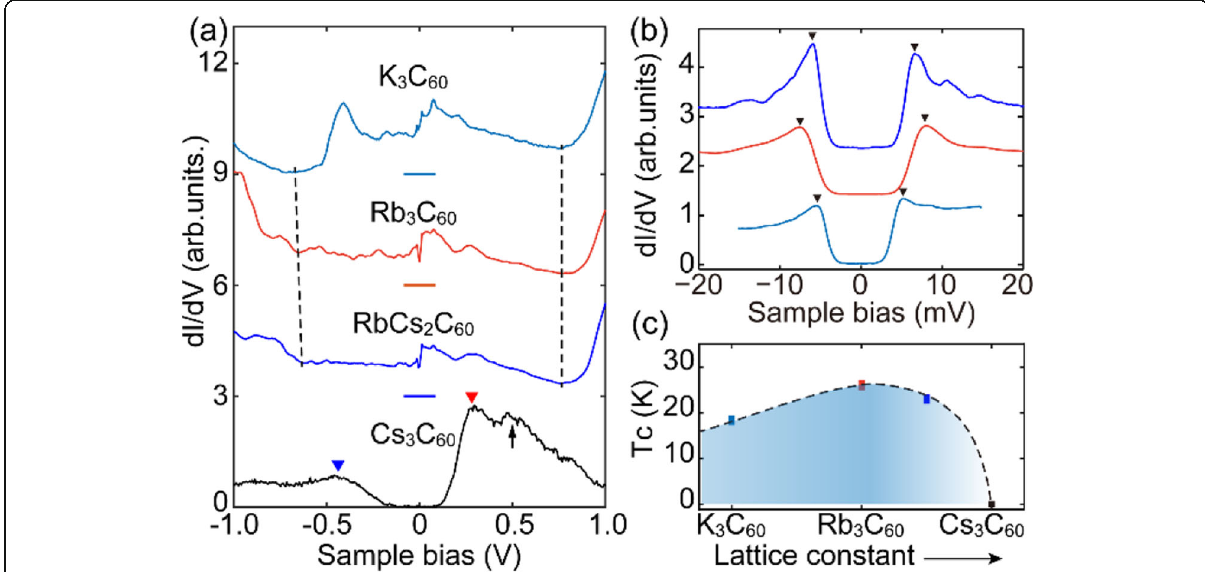
Fig. 8 Bandwidth control of 9 ML A 3 C 60 . ( a ) Low energy-scale d I /d V spectra. The triangles and up arrows donate the LHB/UHB and the satellite peaks from JT distortion, respectively. ( b ) Evolution of superconducting gap taken at 4.5 K. The spectra are color-coded to that in ( a ). ( c ) Electronic phase diagram of 9 ML A 3 C 60 films. Taken from ref. [45,